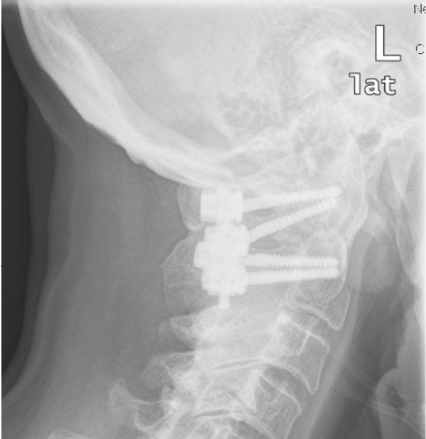
Figure 3: Lateral X-ray of the neck after dorsal stabilisation. The inserted devices are in correct position in all